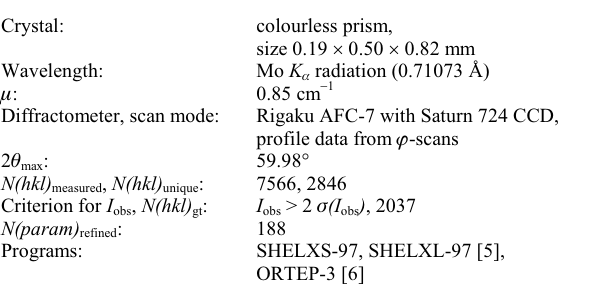
Table 1. Data collection and handling.